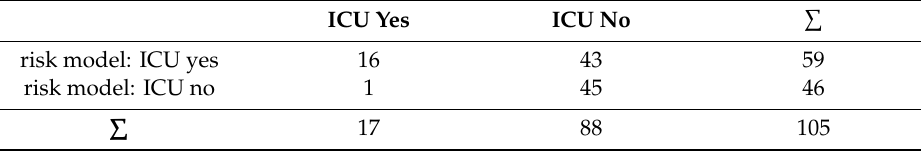
Table A2. Mortality table with age-dependent comparison stratified for donor age (very old donors